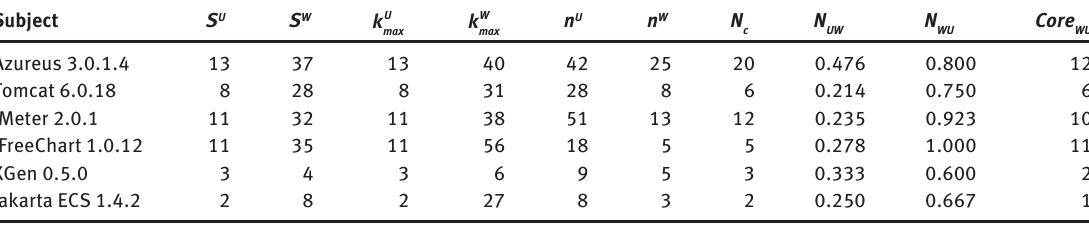
and W k-core k-core